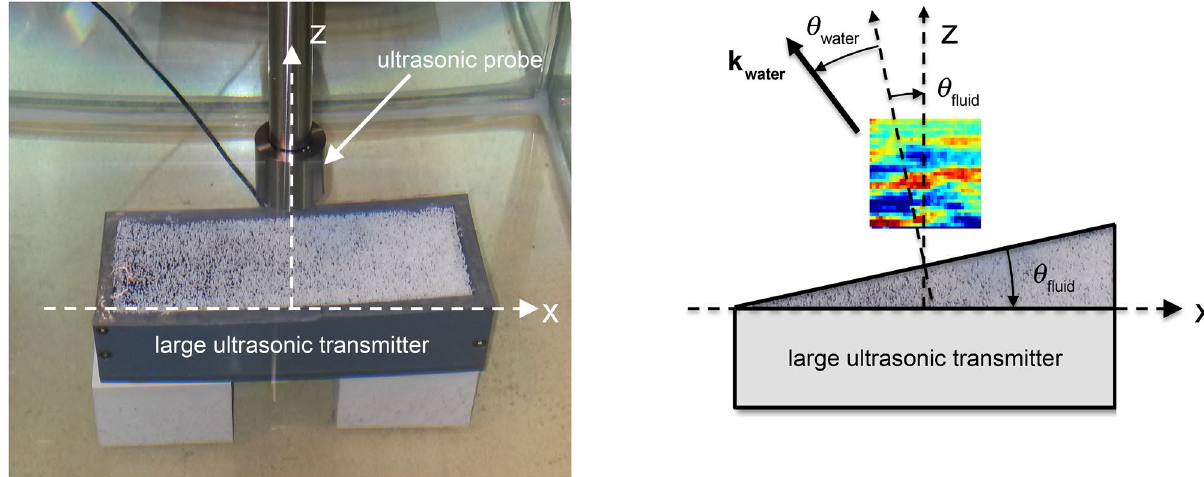
Figure 1. (left) Top view and (right) side view of the experimental setup. The metafluid is confined in a prism- 2 °, that is deposited directly on a large broad-band ultrasonic immersion shaped box, with an angle θ fluid = + transducer (150 mm 40 mm). The acoustic waves propagate from the bottom to the top of the water tank, × along the vertical z -axis. The acoustic field refracted from the prism is scanned in the x – z plane (33 mm 33 × mm) with a small ultrasonic 3% ) and concentrated metafluid two different volume fractions (cid:31) , referred to as the diluted metafluid ( (cid:31) = 17% ). The acoustic properties of the micro-beads are given in a previous work 20 . One of the particular ( (cid:31) = 1 features of these porous particles is their very low longitudinal phase velocity c L (= 120 m s − ) that is due to the softness of the silicone-rubber material 21 .